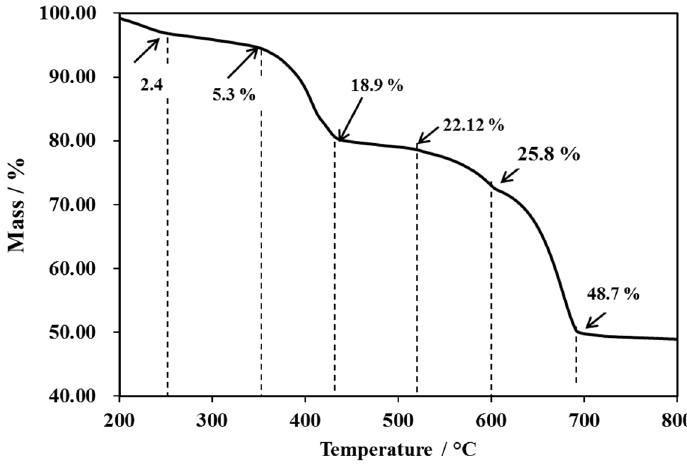
Figure 4. Thermogravimetric analysis curve of ammonium-sodium jarosite with arsenic.